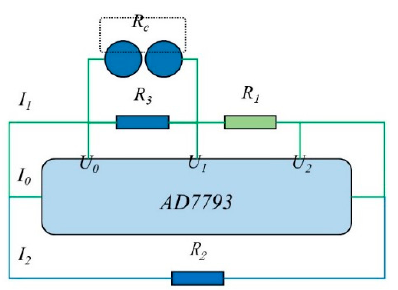
Figure 3. Diagram of the resistance detecting circuit.